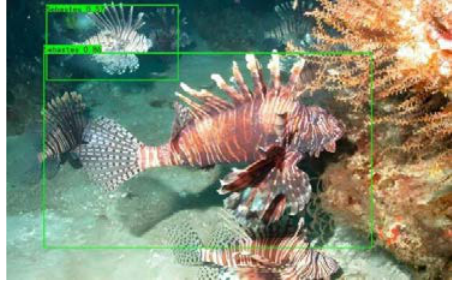
Fig. 9. Detection results of the Sebastes on the YOLOX model.